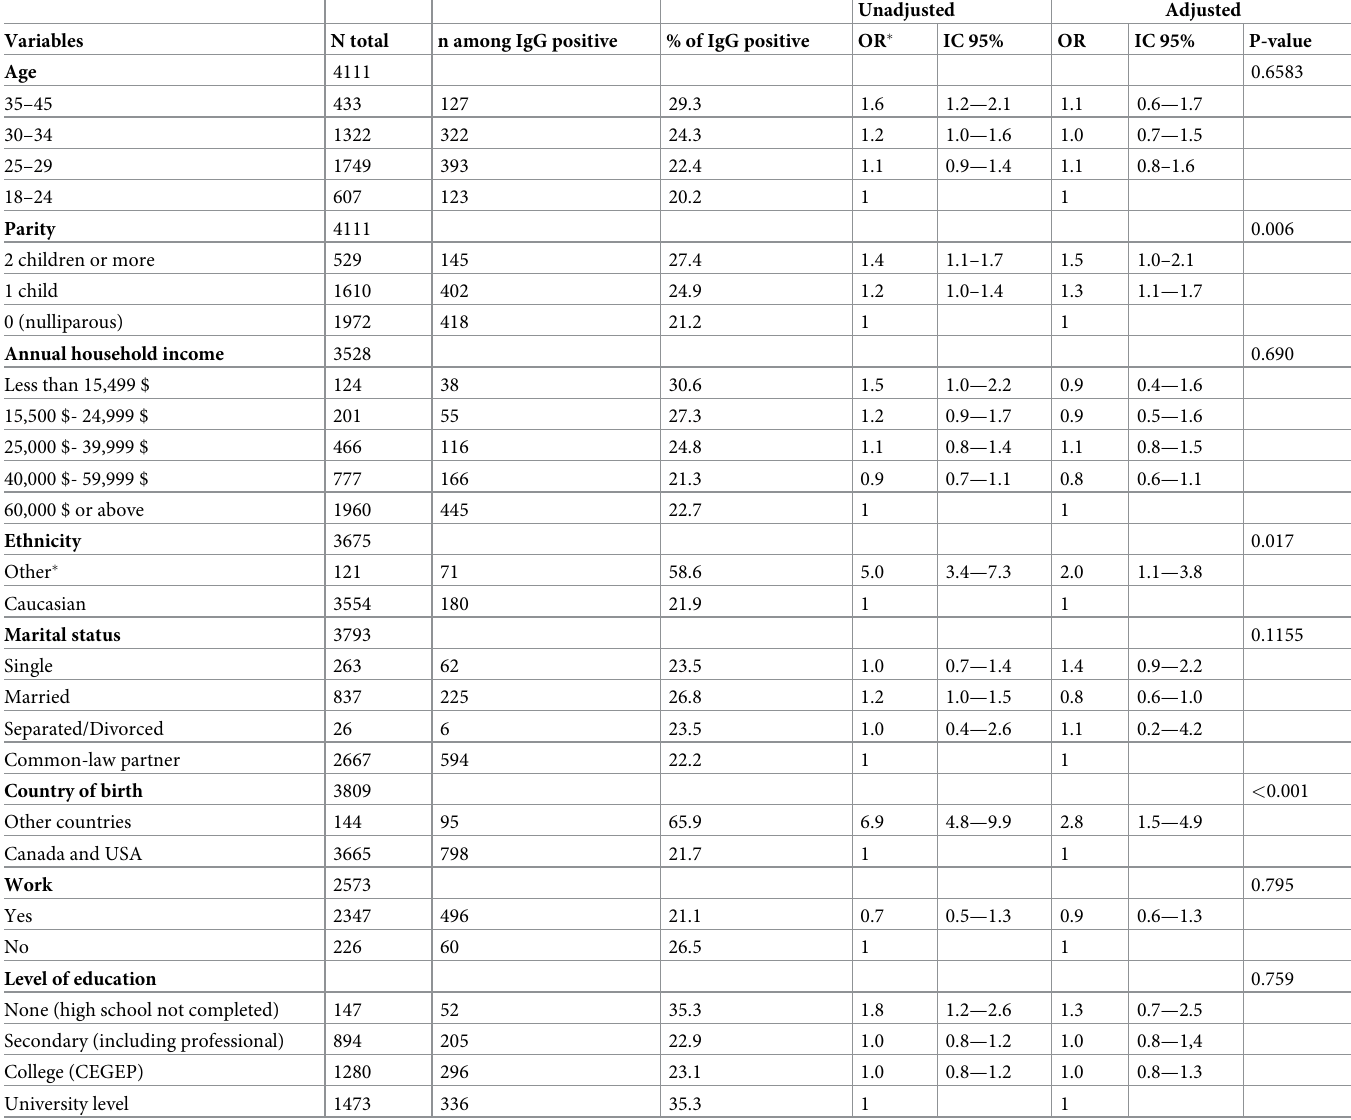
Table 1. Association between CMV IgG seropositivity and socio-demographic